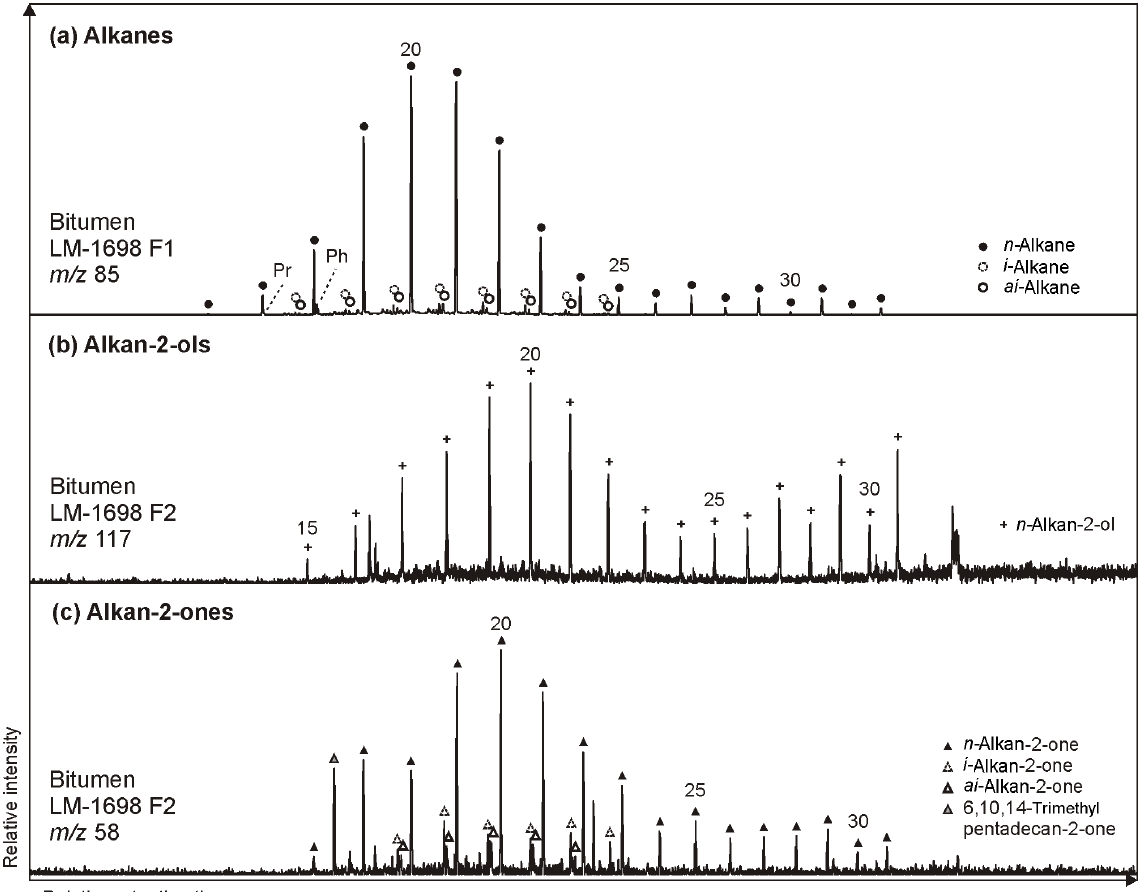
Figure 5. Partial GC-MS ion chromatograms (10–55min) of the hydrocarbon (F1) and derivatized alcohol/ketone fraction (F2; alcohols were measured as trimethylsilyl ethers) from bitumen of the Green Bed chert LM-1698. Medium-chain ( ∼ C 20 ) alkanes ( m/z 85; a ), alkan-2-ols ( m/z 117; b ), and alkan-2-ones ( m/z 85; c ) show similar distributions with no chain-length predominance, while long-chain